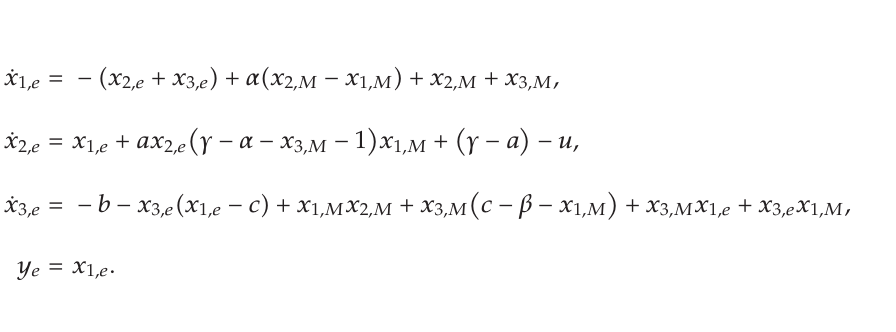
from where the synchronization error system is given